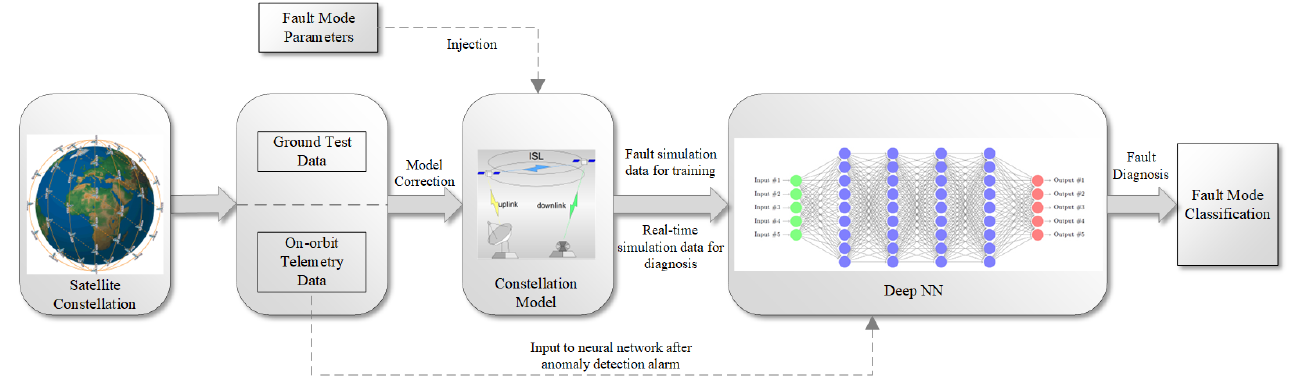
Figure 9. Fault Diagnosis Workflow.